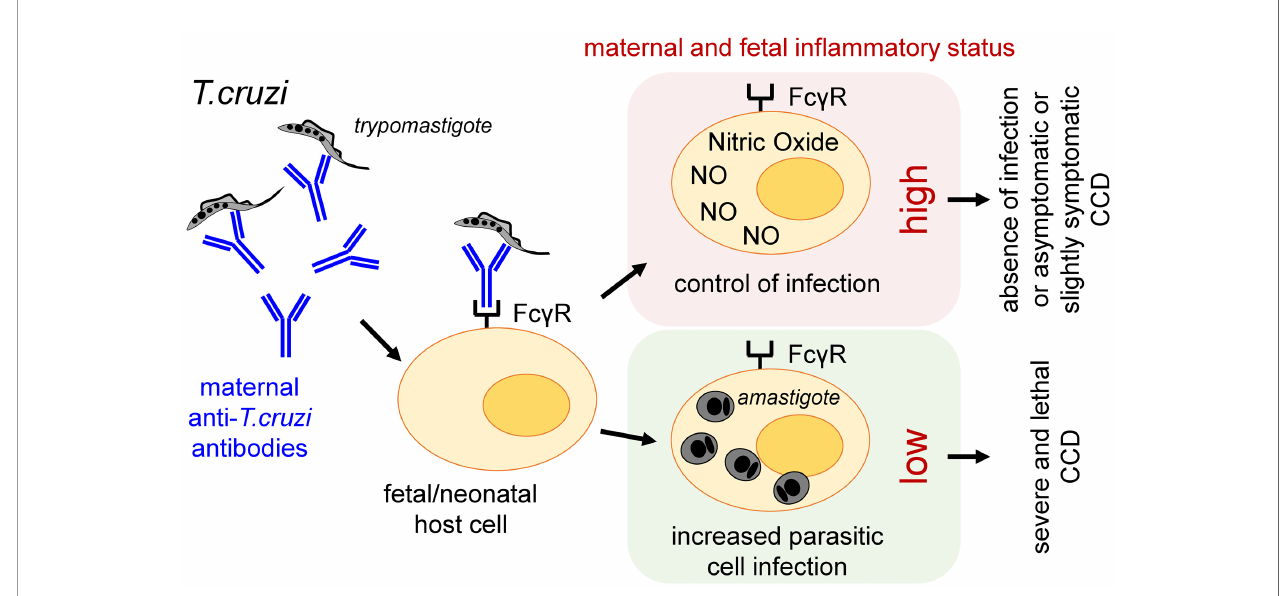
FIGURE 1 | Proposed role of ADE in the development and/or worsening of CCD in